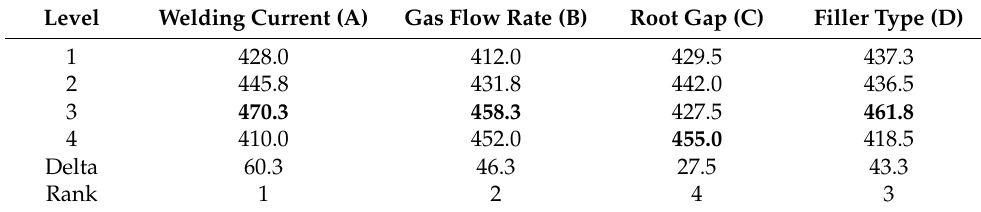
Table 8. Response table for Tensile Strength.